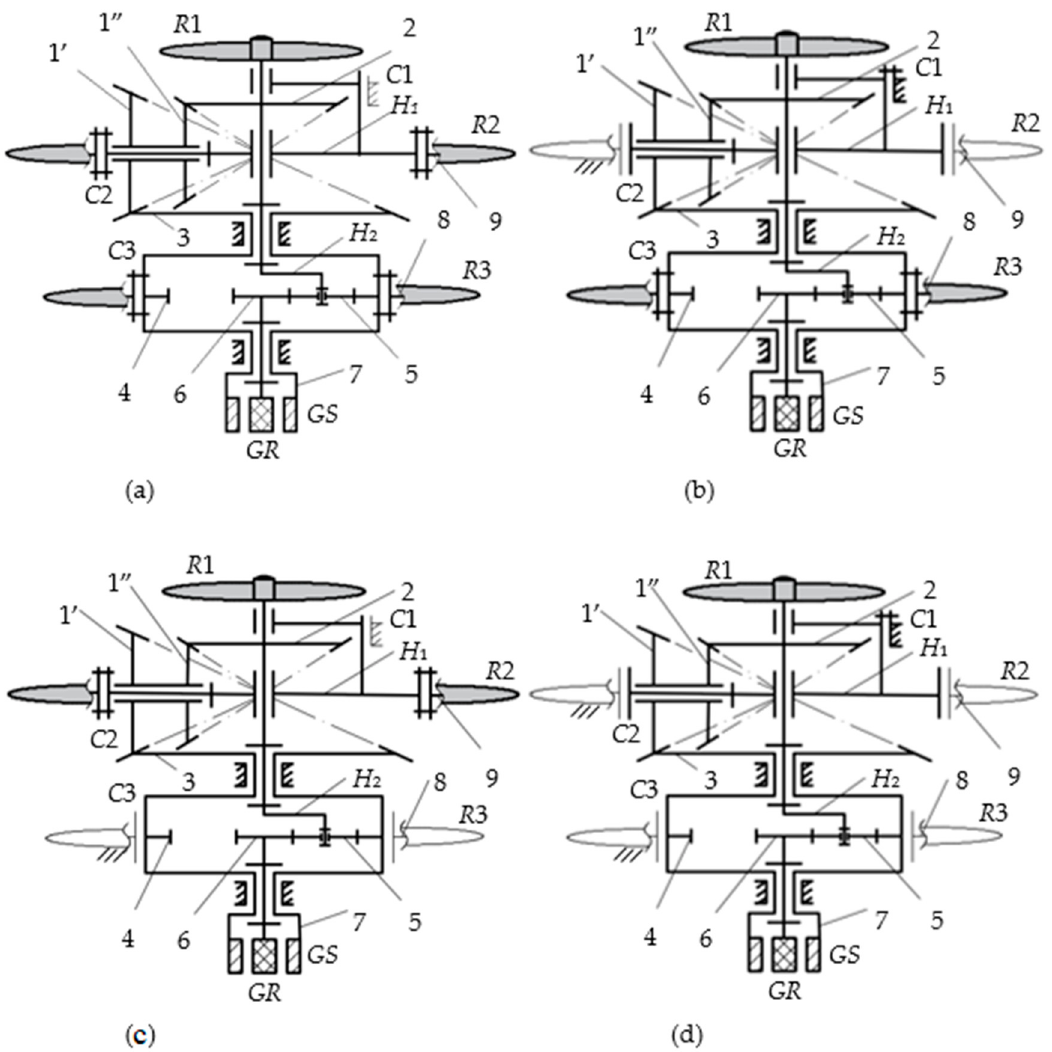
Figure 1. Schemes of the WSCGs with a “variable” structure: ( a ) C 1 = 0, C 2 = C 3 = 1: Case A (2-DOF, L = 5); ( b ) C 1 = C 3 = 1, C 2 = 0: Case B (1-DOF, L = 4); ( c ) C 1 = C 3 = 0, C 2 = 1: Case C (2-DOF, L = 4); ( d ) C 1 = 1, C 2 = C 3 = 0: Case D (1-DOF, L = 3).